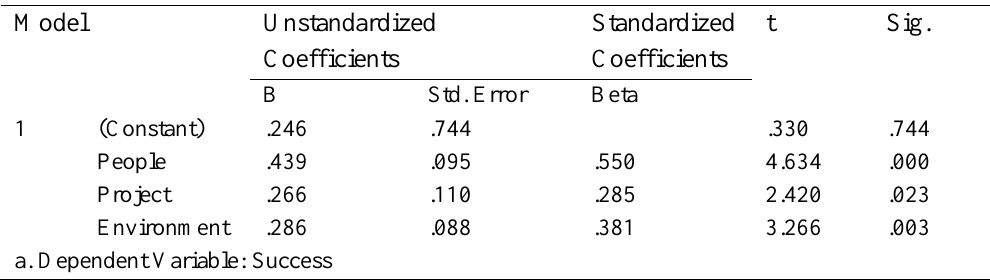
Table 3. Calculating Linear